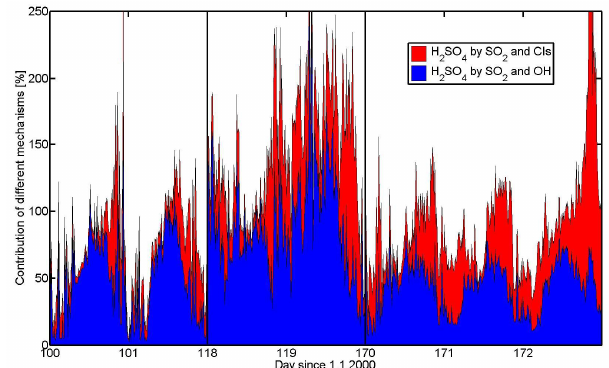
Fig. 9. Cumulative percentage contribution of the different SO 2 ox- idation mechanisms for Hohenpeissenberg.